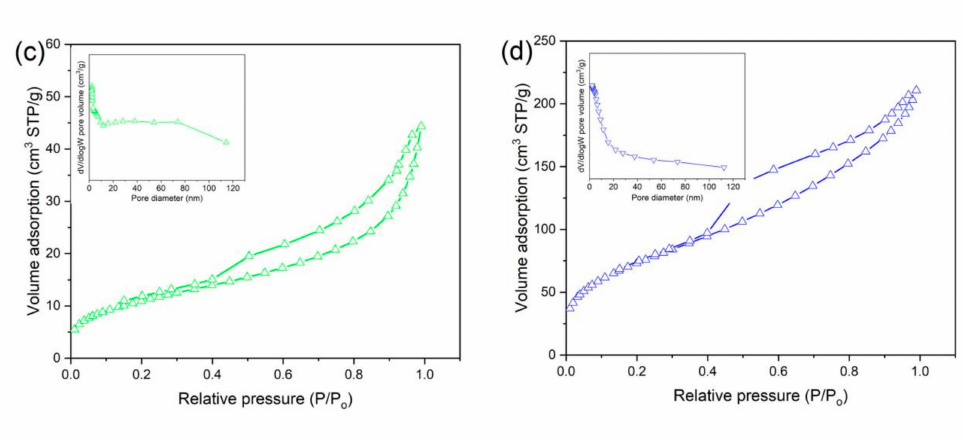
Figure 6. Nitrogen adsorption–desorption isotherm and the corresponding pore size distribution plots of RGO / BiOCl / TiO 2 nanocomposites with various TiO 2 contents: ( a ) 0%; ( b ) 10%; ( c ) 30%; and ( d )